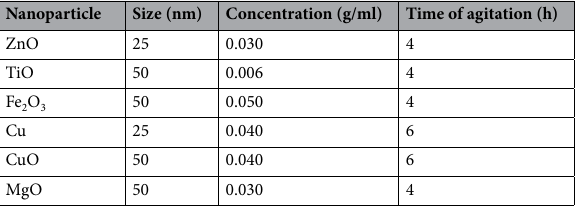
Table 3. Particle size (nm), concentration (g/ml) and time of agitation (h) for different nanoparticles applied to the PDS-II sutures coating.